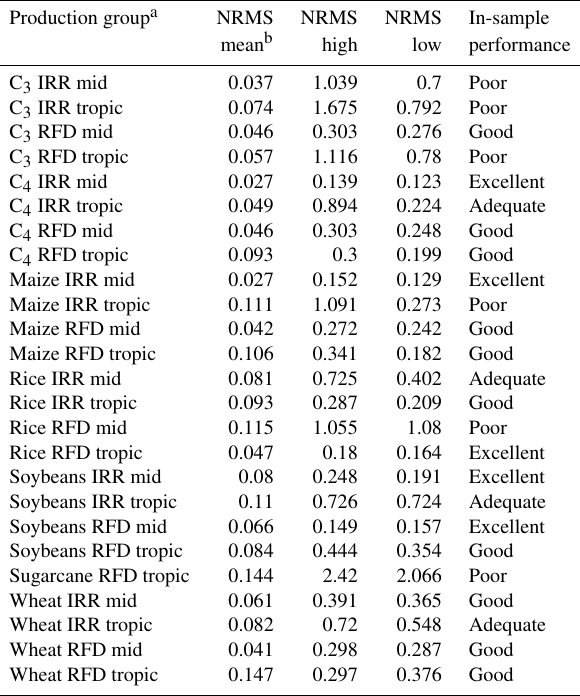
Table A4. Persephone v1.0 response function performance for all production groups, for C3MP µ CTW (Eq. A2), cubic σ CTW (Eq.